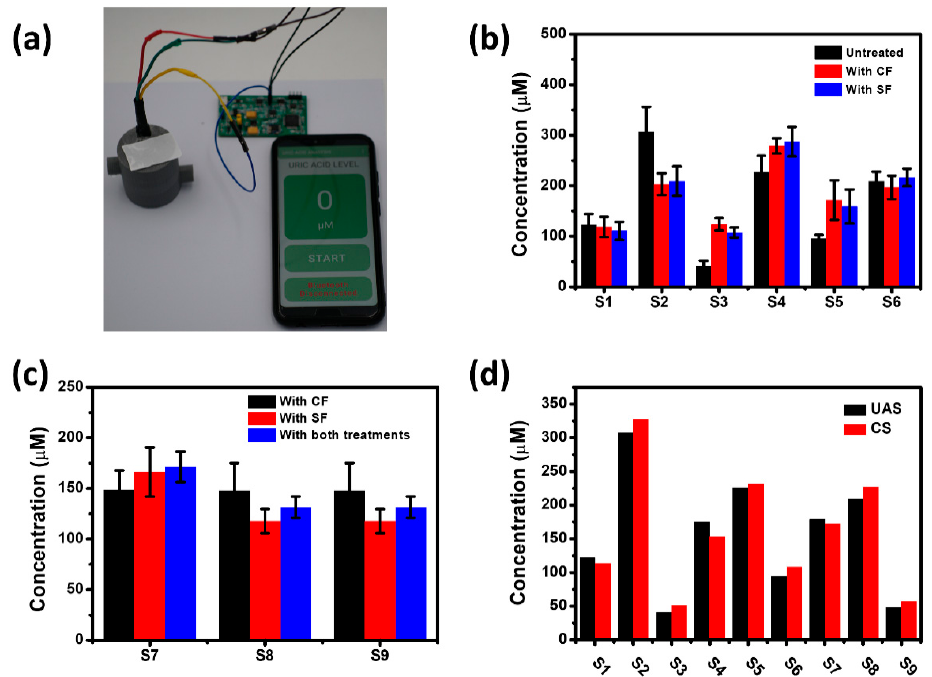
Table 1. Comparison of relative mean uric acid levels and LSD results in real saliva samples after untreated, CF and SF. Figure 7. ( a ) Photograph of the PSSS application scenario. ( b ) Uric acid levels in six groups (S1–S6) of real saliva samples after unprocessed, CF, and SF through the PSSS, respectively. ( c ) Uric acid levels in three groups (S7–S9) of real saliva samples after CF, SF, and both treatments through the PSSS, respectively (The error bars in ( b , c ) are obtained from the standard deviation of the data measured three times per sample). ( d ) Uric acid levels in all nine groups (S1–S9) of real saliva samples tested by the UAS of the PSSS and CS, respectively.